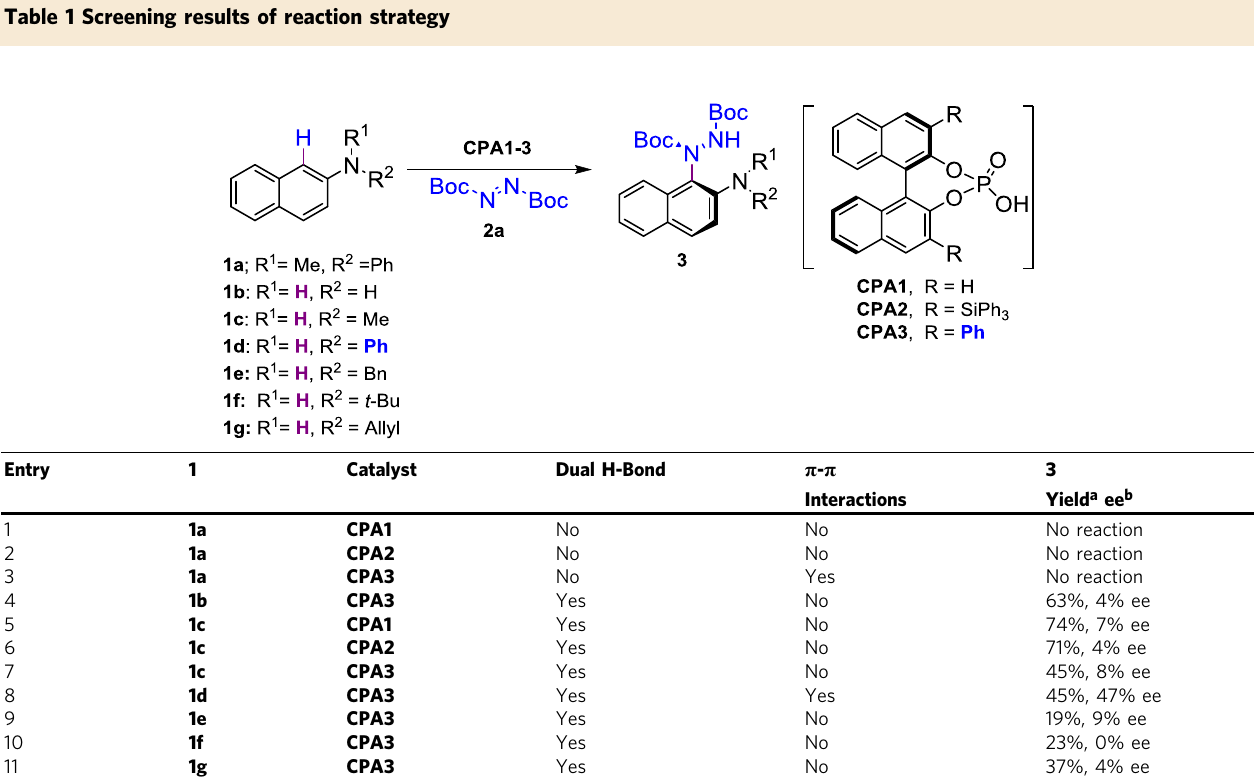
Table 1 Screening results of reaction